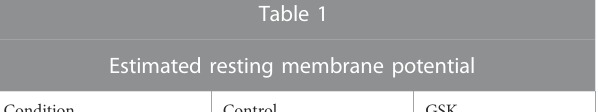
Estimated resting membrane potential